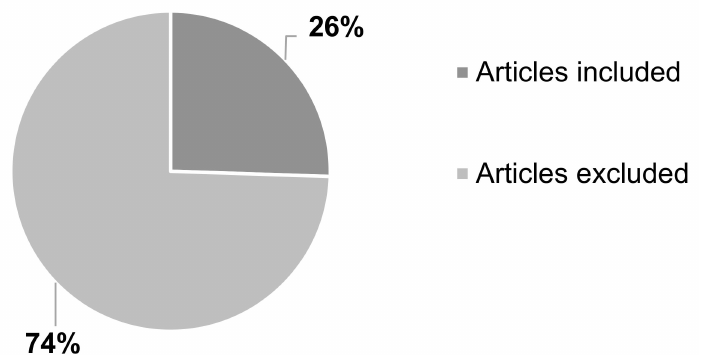
Figure 4. The number of articles included (dark grey) and excluded (light grey) in the systematic review, following the pre-defined inclusion and exclusion